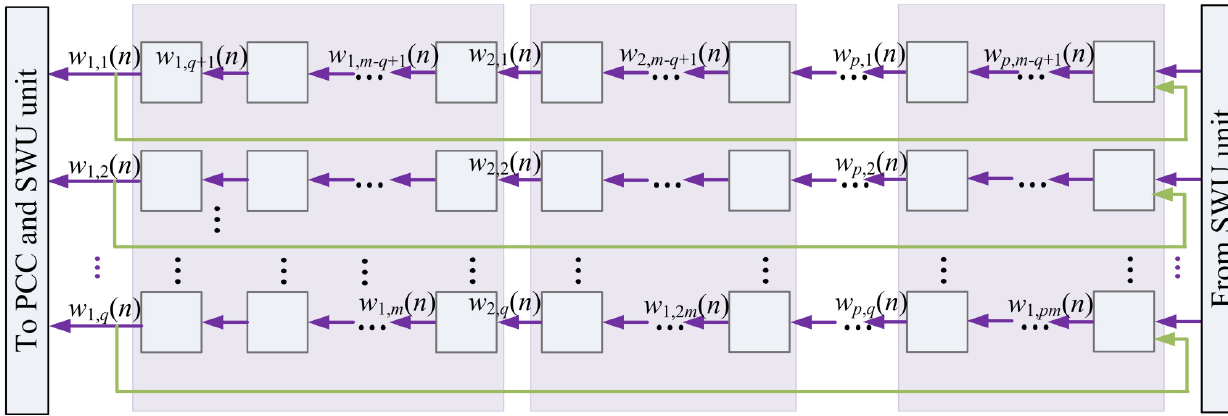
Figure 11. The Buffer C architecture.